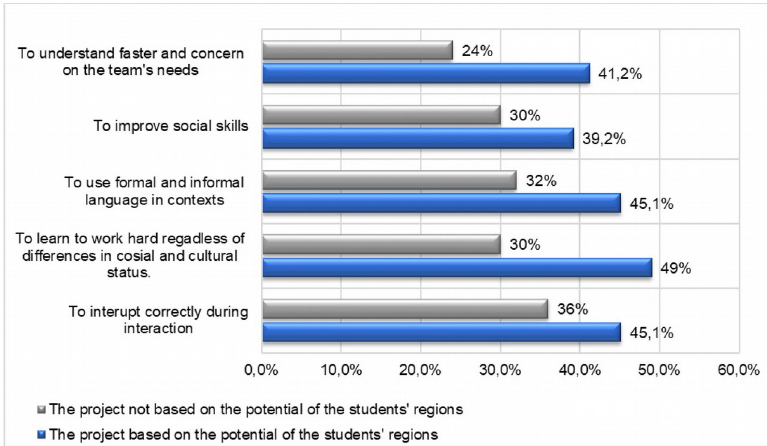
Figure 6. The comparison on students’ perception of Interpersonal